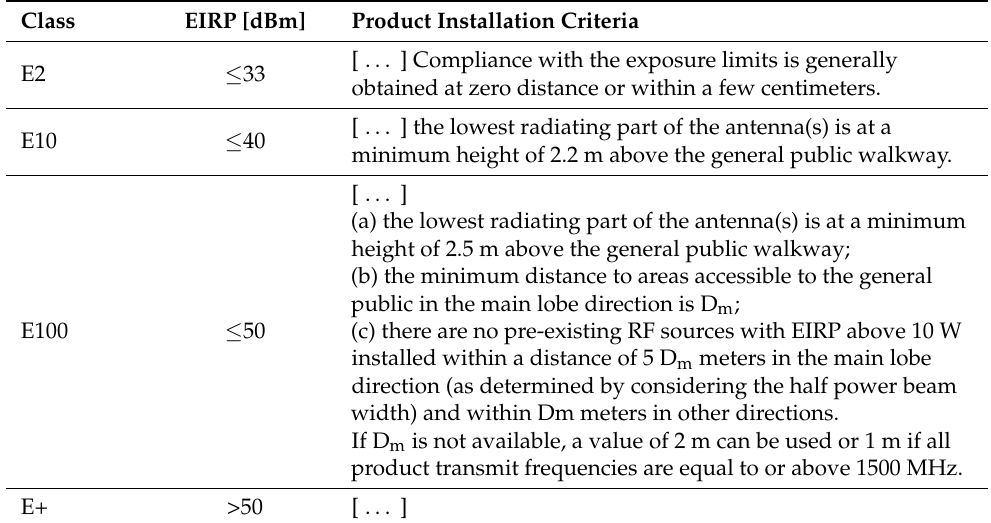
Table 1. The IEC’s simplified safe installation criteria for base station classes [2]. Classes E100, E10, and E2 fall under the general definition of a small